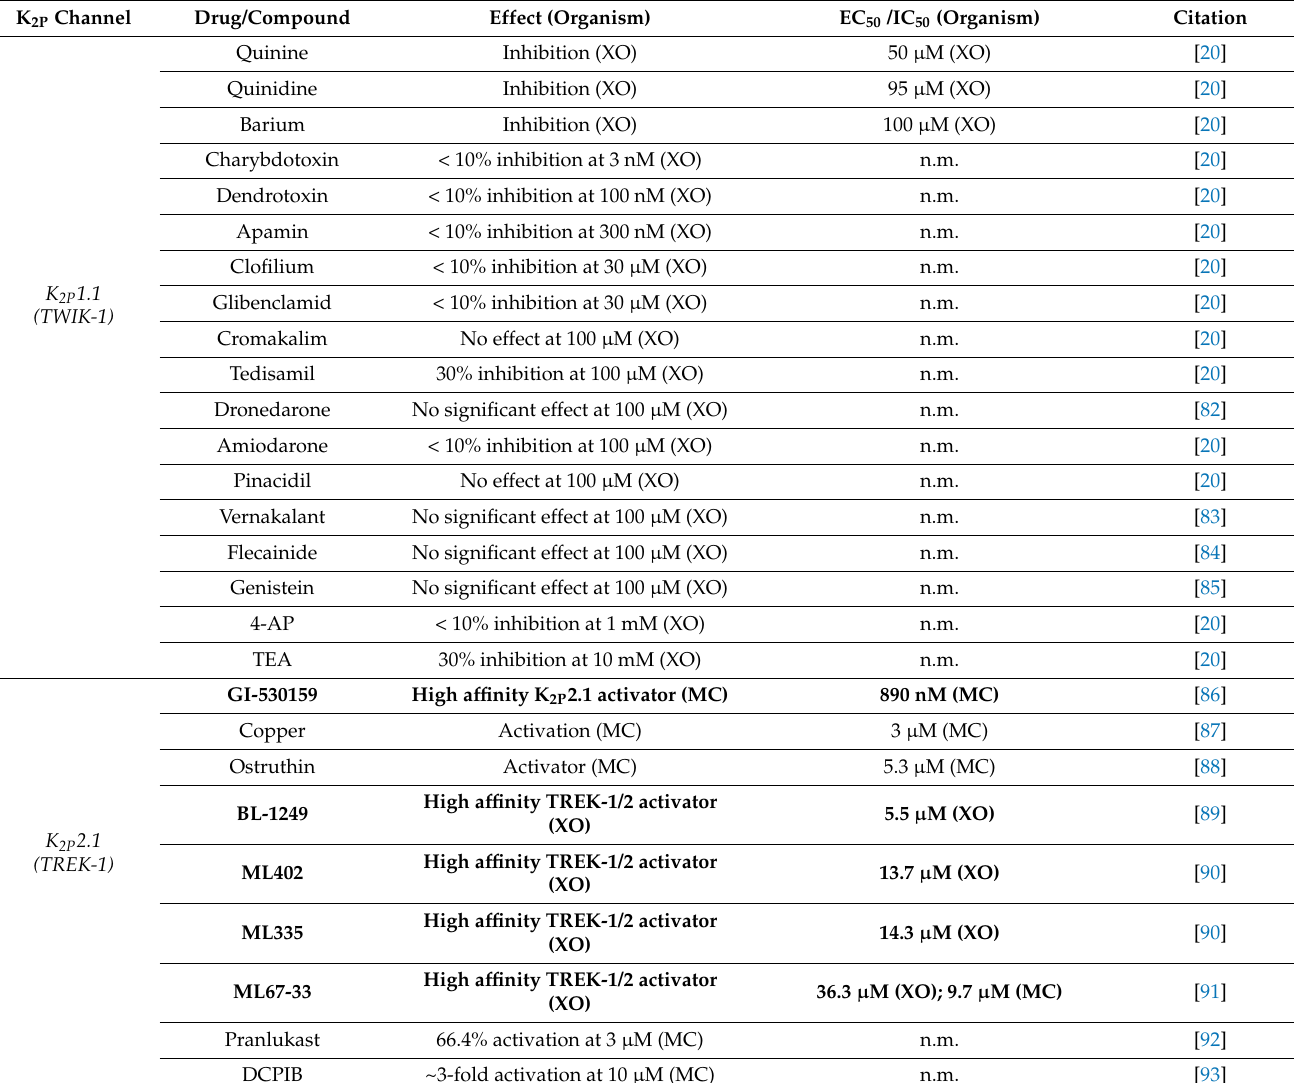
Table 3. Pharmacological profile of K 2P